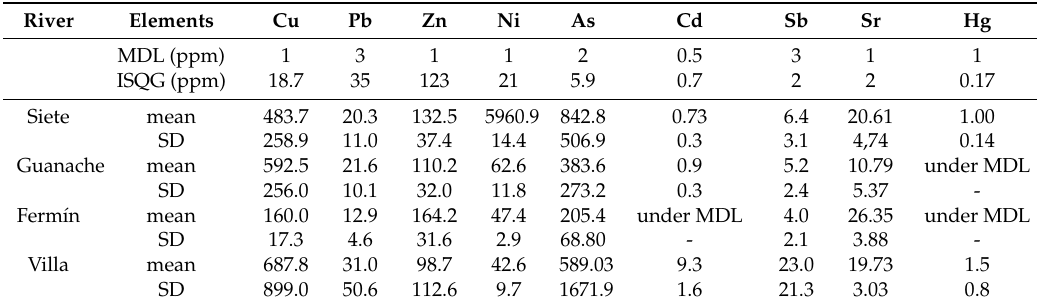
Table 5. Mean values and standard deviations among samples, by river. MDL is the method detection limit.